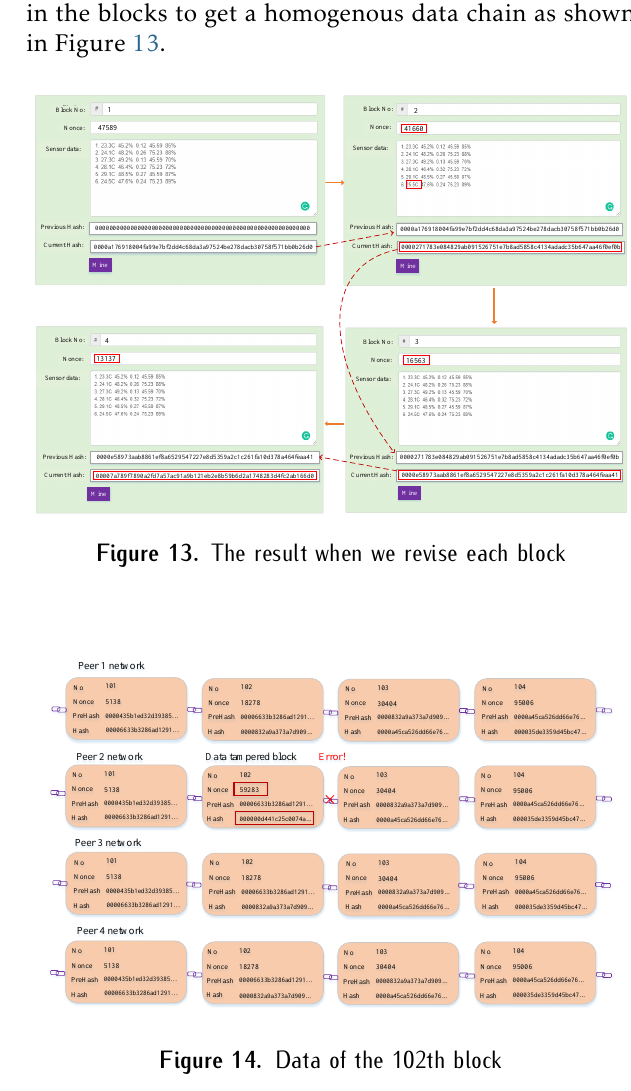
modification and generate a di ff erent code. If we agree to this data change, we will have to update all the hashes in the blocks to get a homogenous data chain as shown in Figure 13.